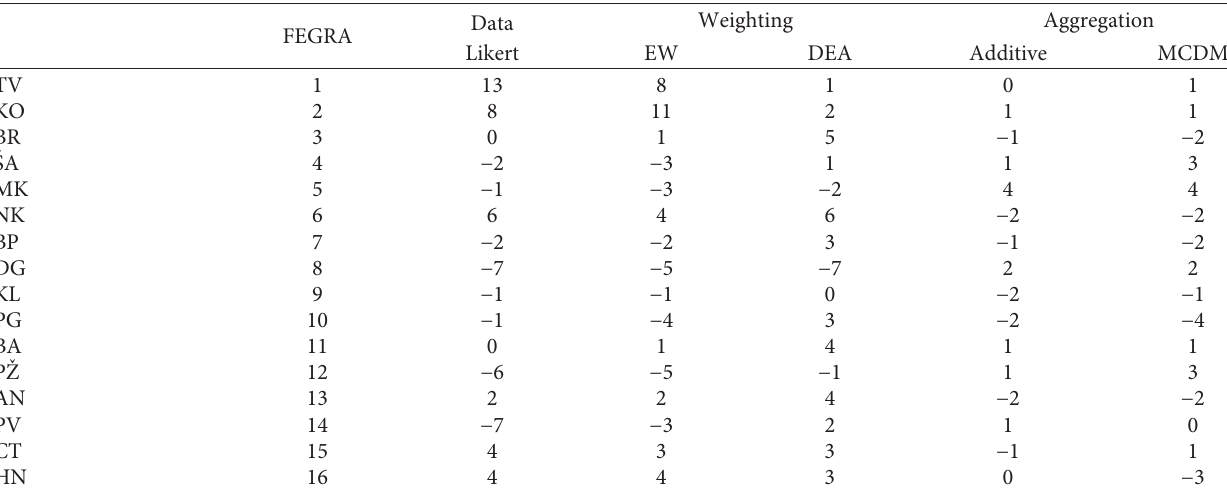
Figure 4: FEGRA ranking: comparison with equal and DEA weighting, (a) and comparison with additive and noncompensatory MCDM aggregation (b). Table 10: Ranking